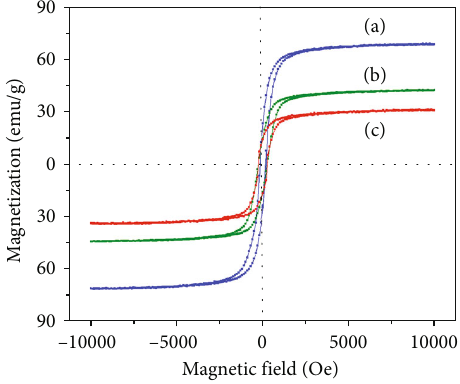
Figure 9: Magnetization curves of (a) Fe @SiO MMSs, and (c) Fe 2